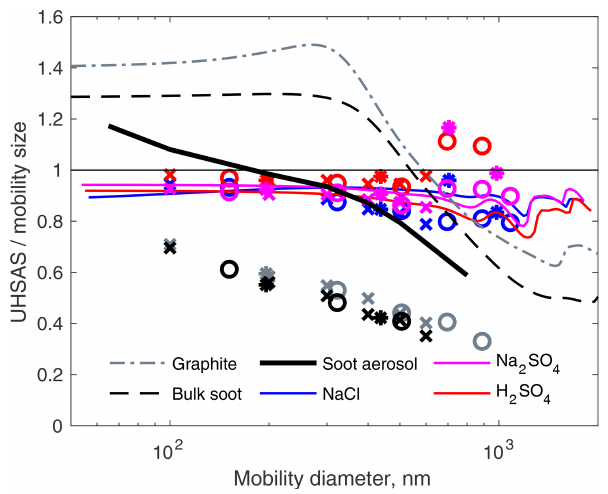
Figure 4. The same data as Fig. 3, but the y axis is the ratio of theoretical UHSAS response (lines) or measurements (symbols) to that of PSL spheres.